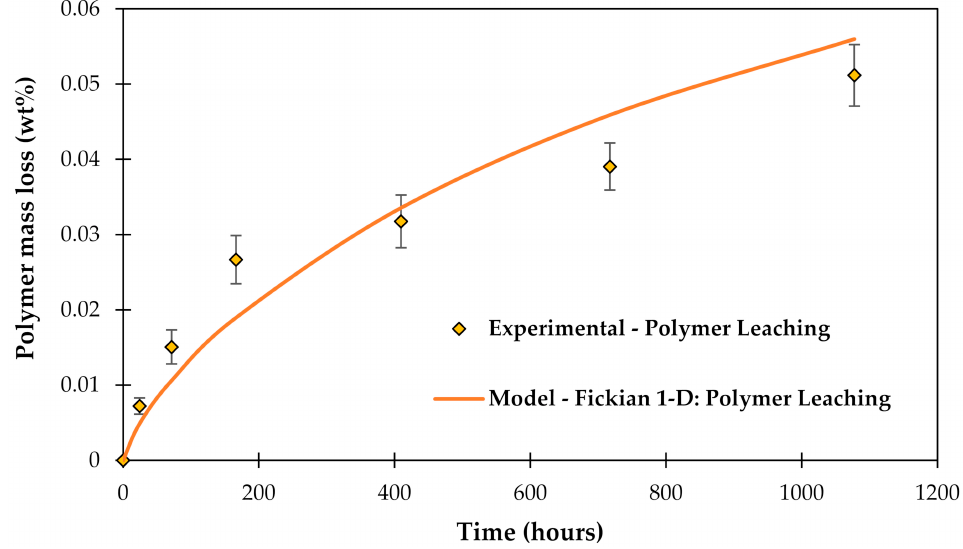
Figure 5. Polymer leaching determined experimentally with HR-ICP-MS, after [46], and modeled using Fickian 1-D model, after [61].